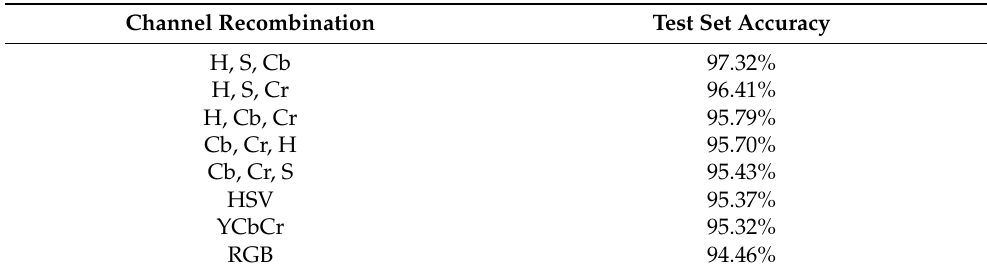
Table 3. Experimental results of different channel combinations (model network without channel attention module).